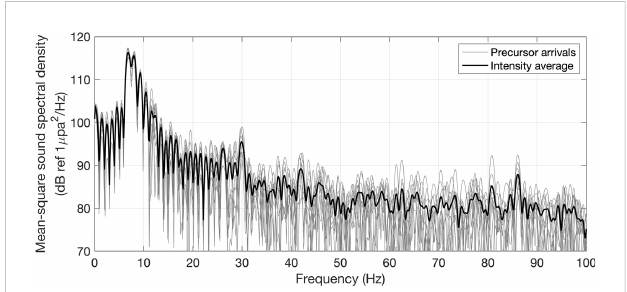
FIGURE 6 Mean-square sound spectral densities of precursor arrivals. The spectrum levels of 10 pulses and their intensity average are represented by thin gray lines and thick black line, respectively.